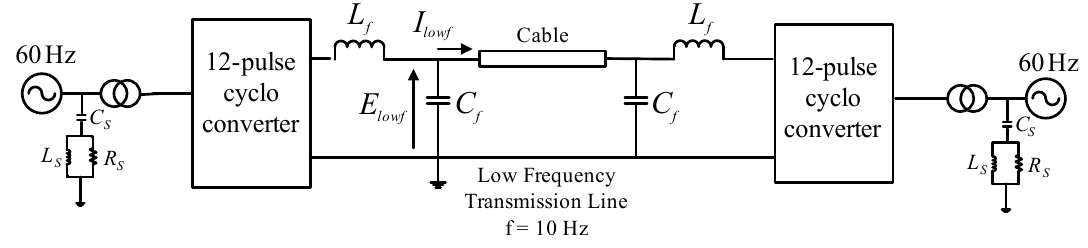
Figure 13. The simulated LFAC system configuration. Table 1. Parameters of the simulated system.